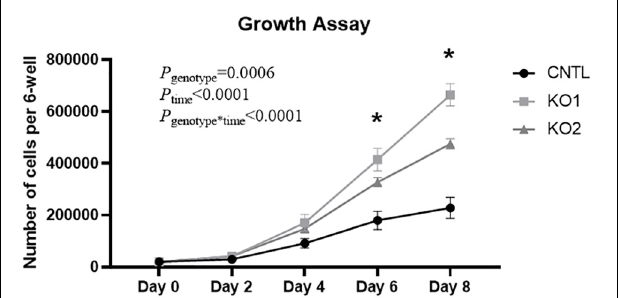
FIGURE 8 | KO of EDN1-AS Regulatory Elements Results in Increased Growth Rate of HK2 Proximal Tubule Cells. Because high expression of ET-1 is known to lead to cell proliferation in kidney proximal tubule cells, growth rate of CNTL and CRISPR/Cas9 KO cells was measured. 20,000 cells were plated into a 6-well dish and allowed to grow under normal conditions for 2, 4, 6, or 8 days. An automated cell counter was used to determine the total amount of cells in each well. Two-way ANOVA with repeated measures was used to determine genotype differences. ∗ P < 0.05 by T- test within 1 day denotes that both KO cell lines are significantly different from the CNTL cell line, n =